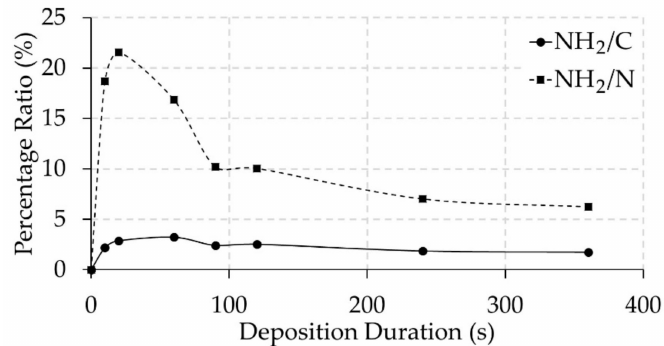
Figure 4. Evolution of amino grafting e ffi ciency (NH 2 / C) and amino selectivity (NH 2 / N) as a function of plasma deposition